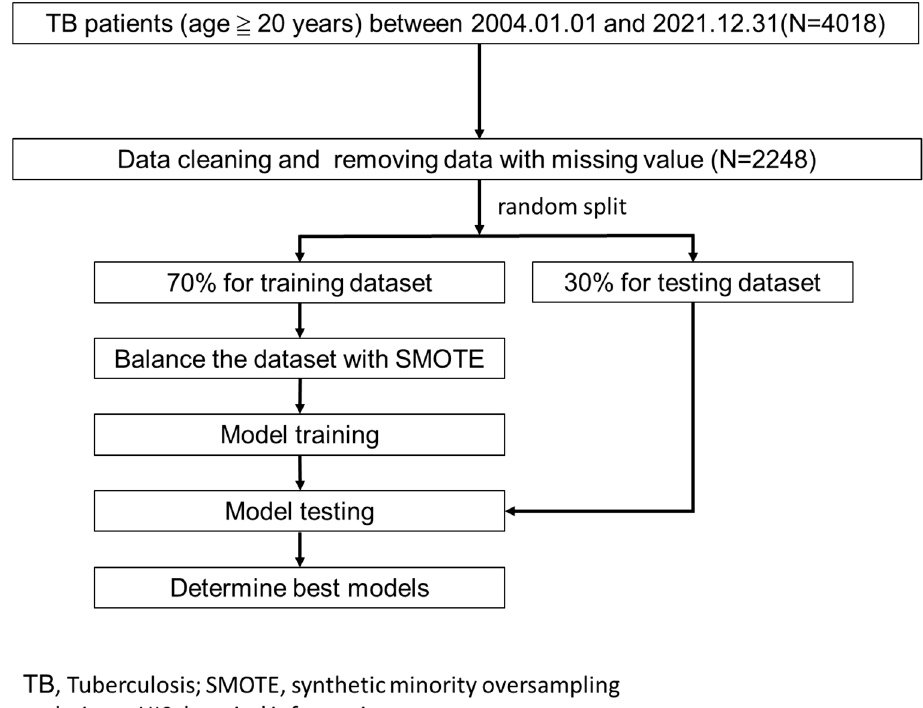
Figure 1. Research Figure 1. Research fl ow.